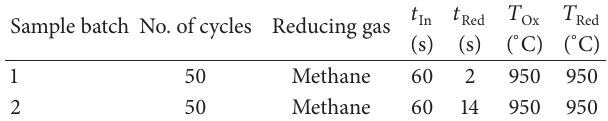
Table 4: Experimental scheme for stability